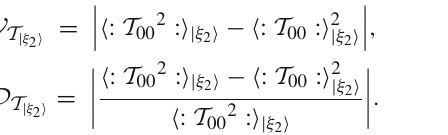
Using TMSV states formalism, squeezing operator identities and action of ladder operators (refer Sect. 3.2), we obtained the expression for (cid:2): ˆ π 4 α :(cid:3) , (cid:2): ˆ π 2 α and then by making use of the Eqs. (45)–(49) along with the approximation ansatz given in Eq. (50), the expression further reduces and are given respectively as: (where Φ = ( p π + 2 m τ) ; with this choice of radian values of squeezing angle of TMSV states, the semiclassical gravity do not show any oscillatory behaviour of the scale factor even during the phase of scalar field oscillatory